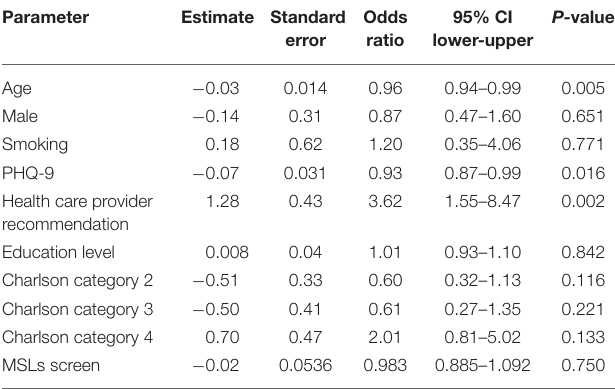
TABLE 4 | Predictors of CR